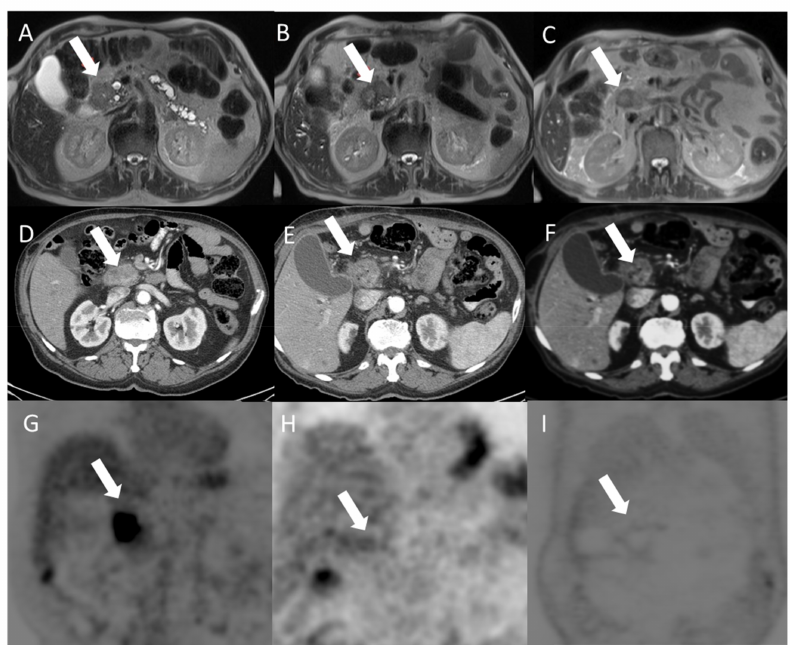
Figure 6. Patient with adenocarcinoma of the pancreatic head treated with variable geometry. Before treatment, the arrow identifies the lesion on the HASTE T2-W sequence ( A ); after one month of treatment, on the HASTE T2-W sequence ( B ), there were not significant differences in signal intensity and lesion size; after six months from ECT, the HASTE T2-W sequence ( C ) showed significant differences in signal intensity and lesion size. In the pancreatic phase of the CT study ( D ), the lesion appeared hypodense (arrow). After one month of treatment, the lesion appeared more hypodense ( E ); after six months of treatment, on CT ( F ), there was also a significant reduction of the lesion size. Also, PET evaluation between pre- ( G ) and post-treatment detected a reduction of glucose uptake both after 1 month ( H ) and after 6 months ( I ) by ECT. According to data, the patient, after one month and after six months, was classified to be in partial response by